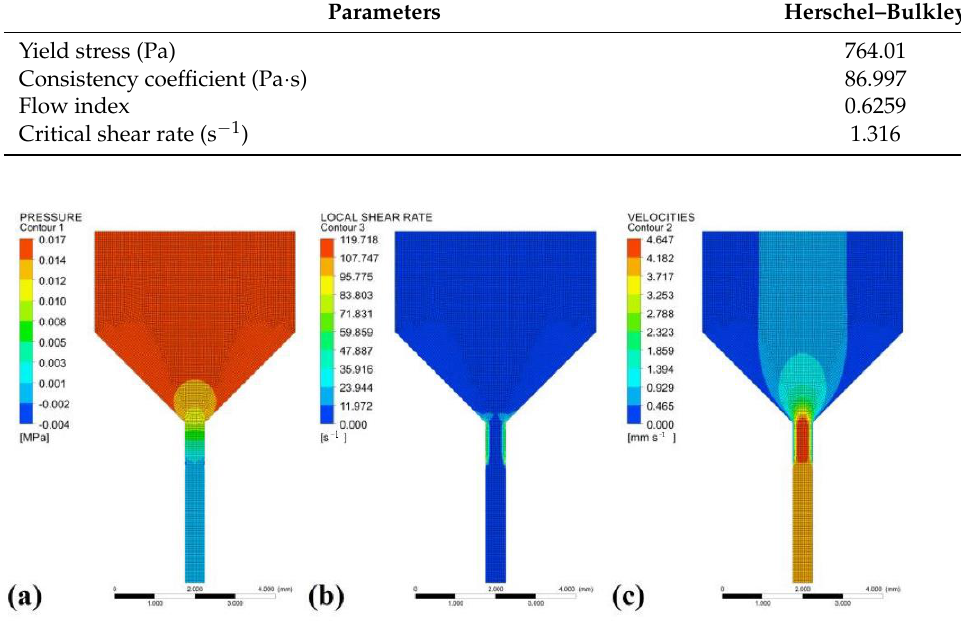
Figure 3. Fluid simulation model: ( a ) flow field and free flow field; ( b ) meshing; ( c ) boundary conditions. Table 1. Parameters of Herschel–Bulkley model.